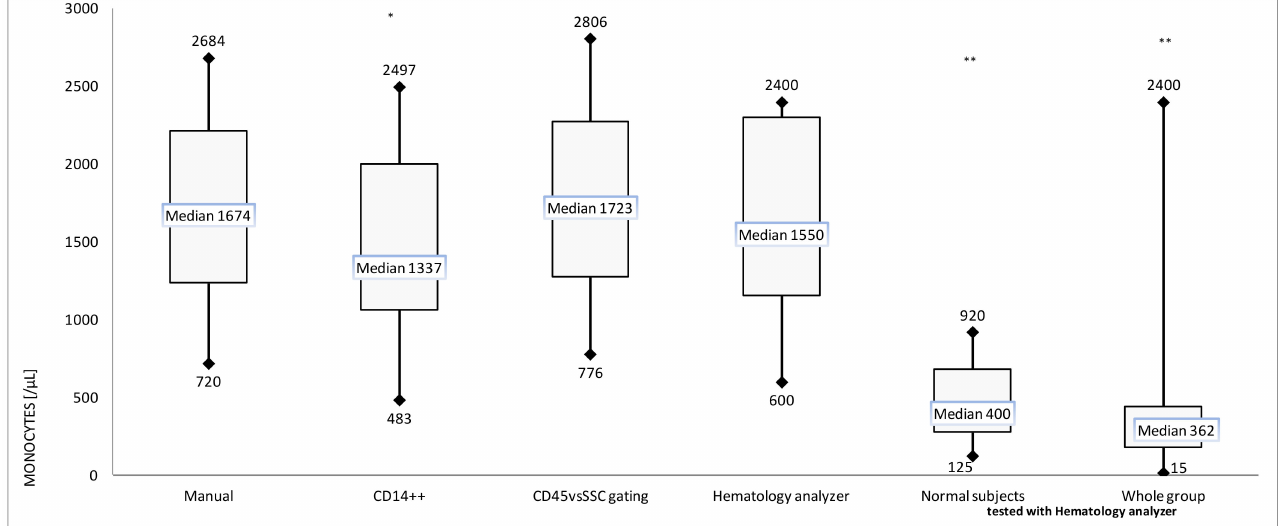
Figure 2. Box and whisker plot for the monocyte level in patients with CMV infection in exponential phase of infectious process; * p < 0.05; ** p <